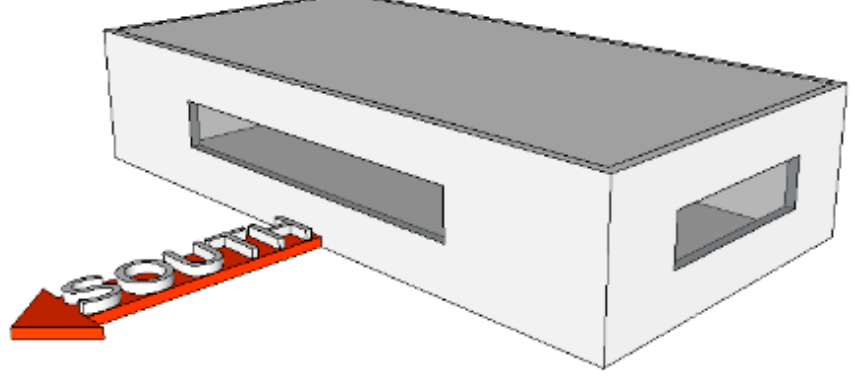
Figure 2. Schematics of a simple simulated building in TRNSYS.